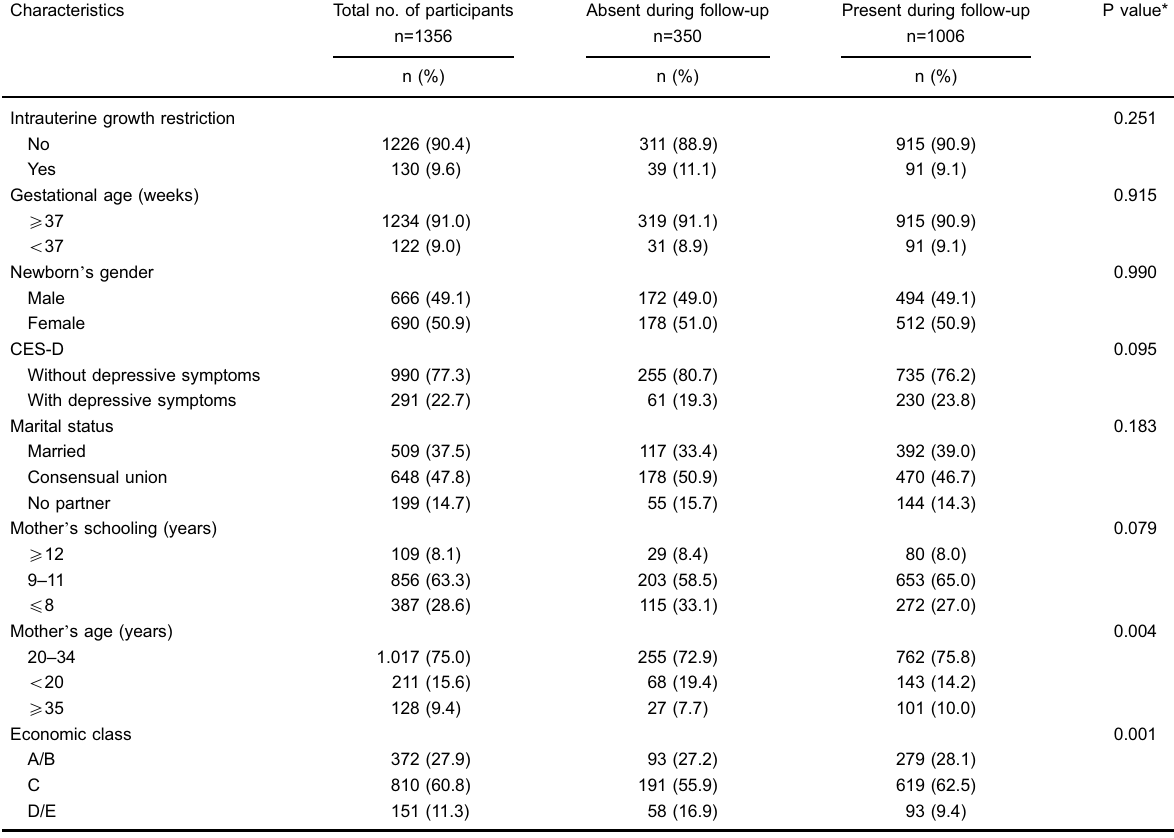
Table 1. Characteristics of the participants who were present or absent during follow-up in Ribeirão Preto, SP, Brazil, 2010/13.